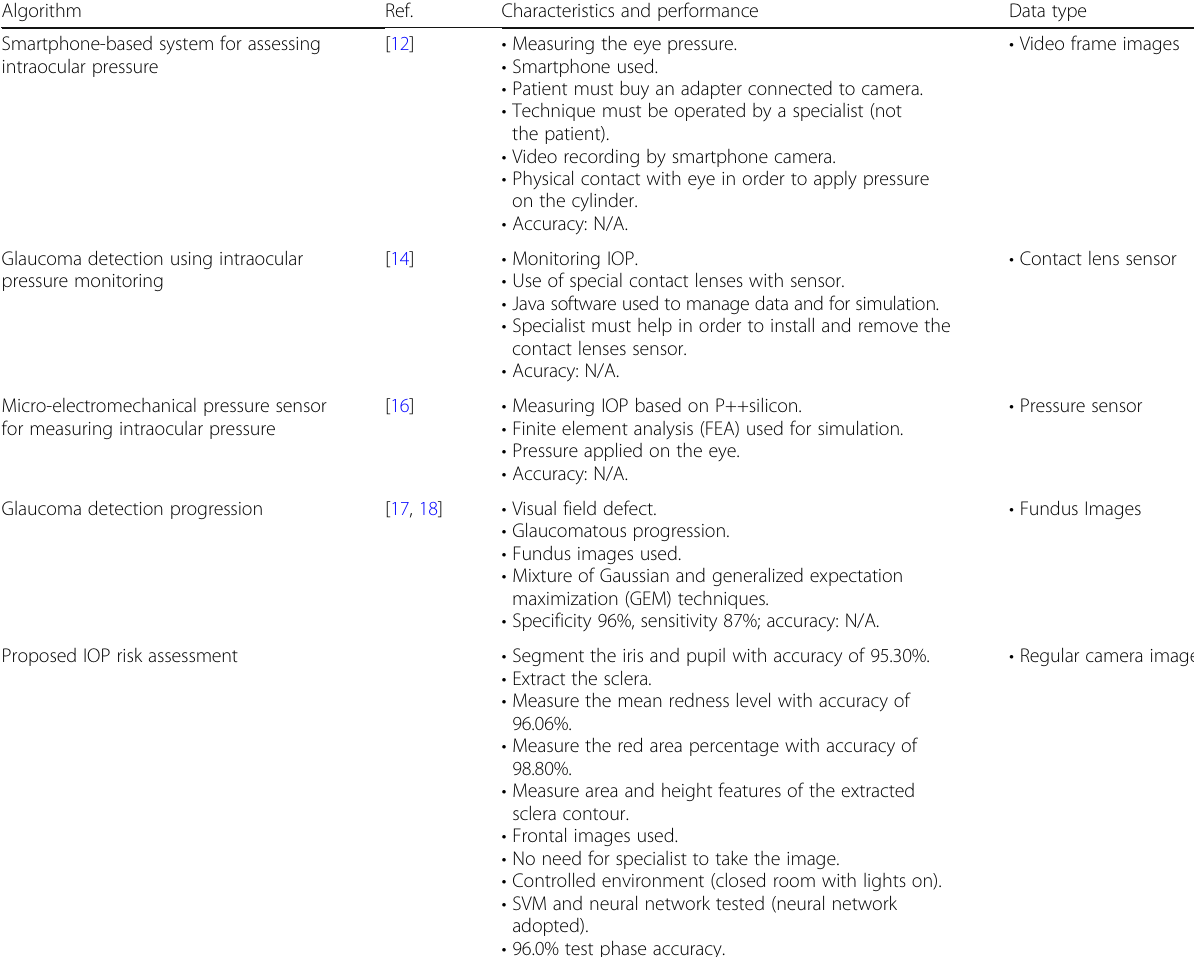
Table 2 Summary of related techniques Algorithm